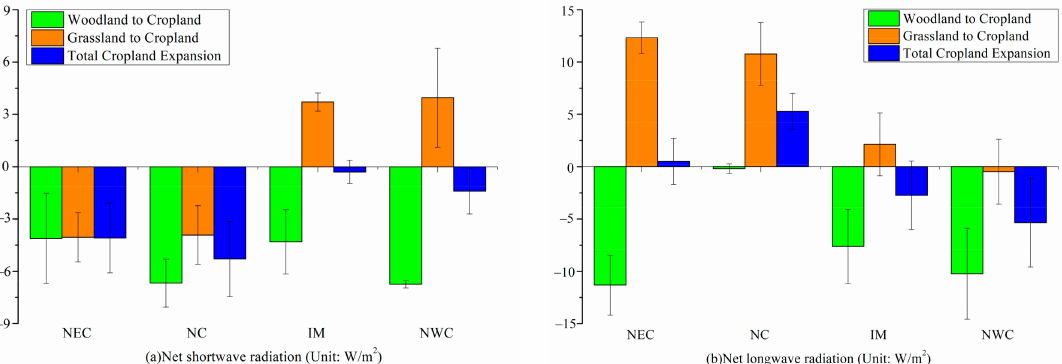
Figure 7. Changes of net shortwave radiation ( a ) and net longwave radiation ( b ) in different climate